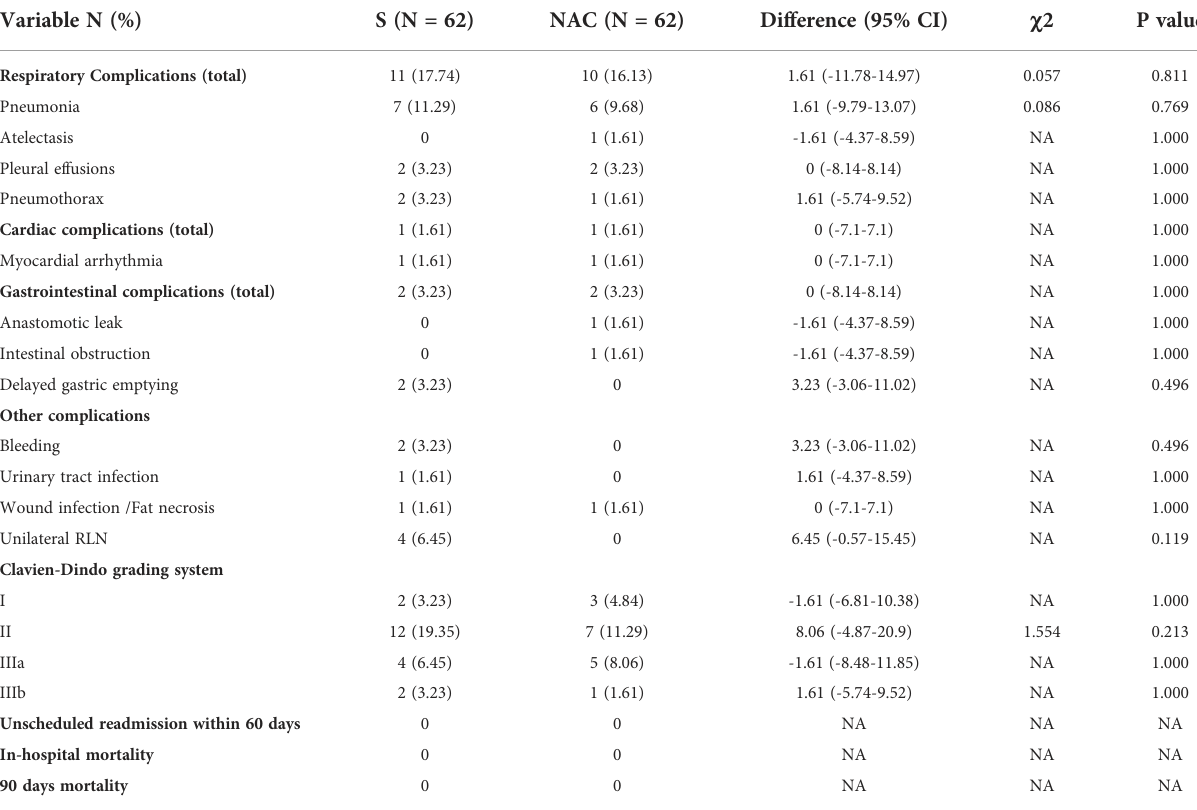
TABLE 3 The postoerative complications in two